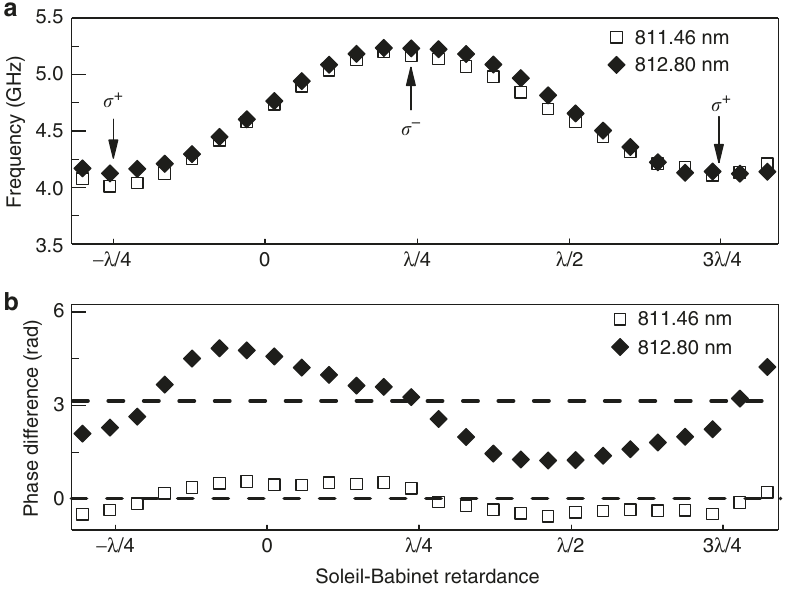
Fig. 5 Helicity and wavelength dependence of the nuclear focusing. a Larmor precession frequency of electron spins for a pump wavelength of 811.46 and 812.80 nm as a function of the average pump helicity (set by an additional Soleil-Babinet compensator) at B = 0.93 T applied 8° out of the plane of the sample. Arrows with labels σ + and σ − indicate maxima of average pump helicity. At a retardance of 0, the polarization of the pump is equally modulated between σ + and σ − . b Phase difference of spin precession at negative and positive time delay at t = 0 ps for pump excitation at 811.46 nm (mode-locking) and 812.80 nm (anti-mode-locking). Horizontal dashed lines indicate expected lines of constant phase for a mode-locked (phase difference 0) and anti- mode-locked (phase difference π ) spin